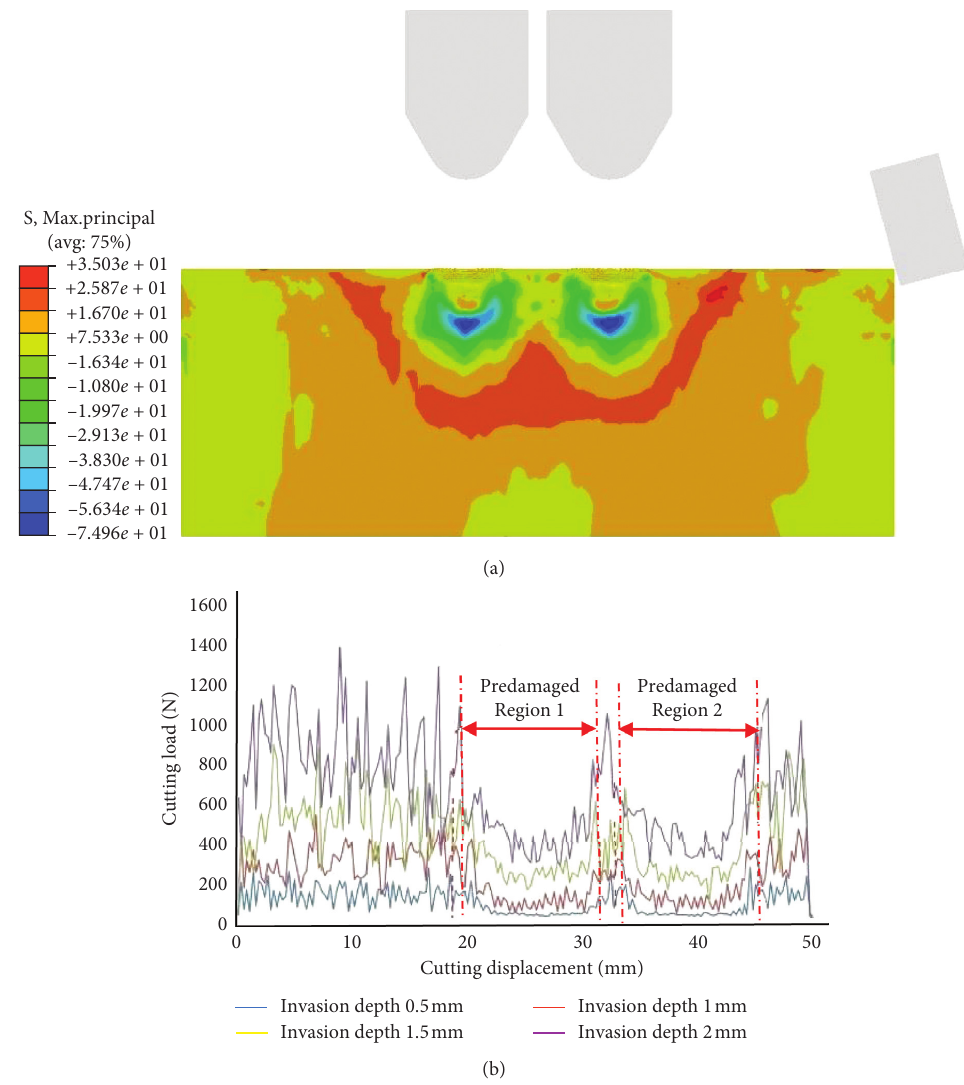
Figure 4: Comparison of cutting load and PDC gear cut rock diagram under predamage action. (a) Distribution of rock stress field during predamage. (b) PDC tooth cutting load curve at different relative heights.